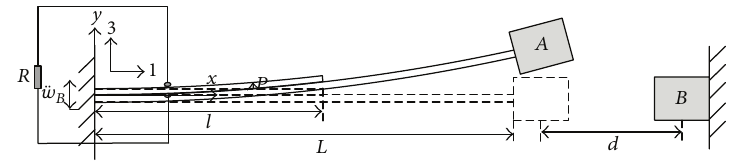
Figure 1: Schematic of the bistable piezoelectric cantilever generator.